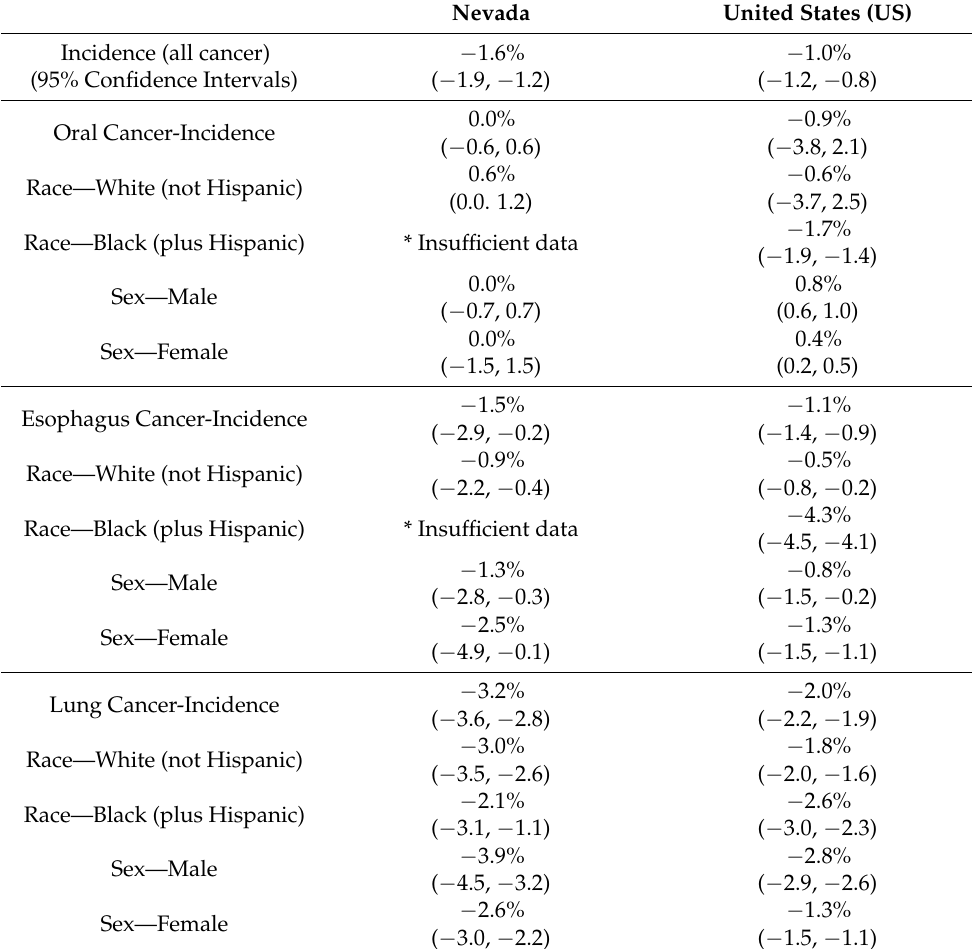
Table 1. Comparison of National (US) and Nevada-specific incidence rates of oral and pharyngeal, esophageal, and lung